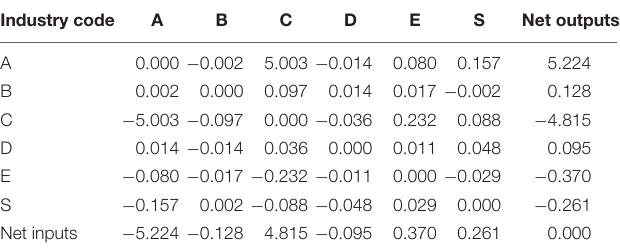
TABLE 3 | Sectoral transfer of virtual water of Zhangye in 2017. Industry code